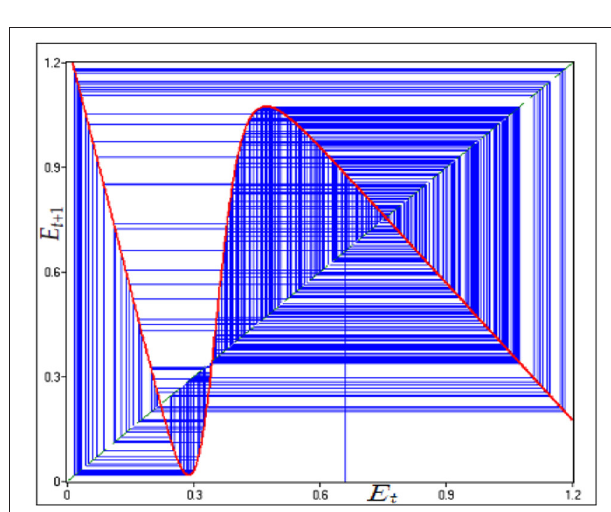
FIGURE 4 | Merger of the attractors, A =